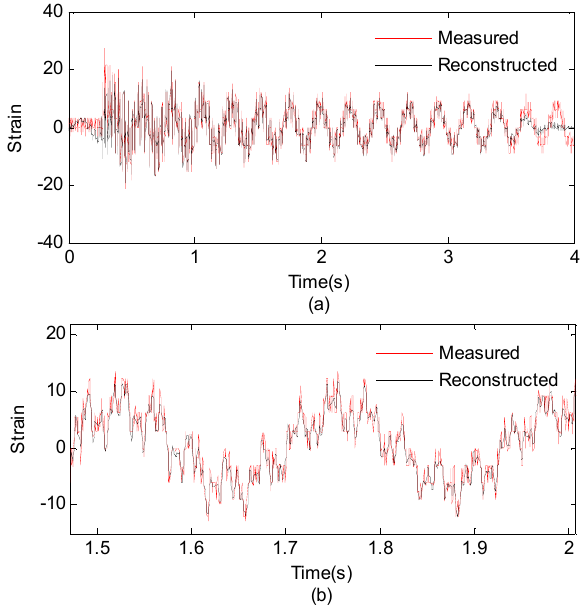
Figure 17. ( a ) Reconstructed and theoretical strain responses for the location of interest. ( b ) Results are concentrated on 4-6s for clear presentation. Table 4. Frequency ranges for each band-pass filters for the experiment.